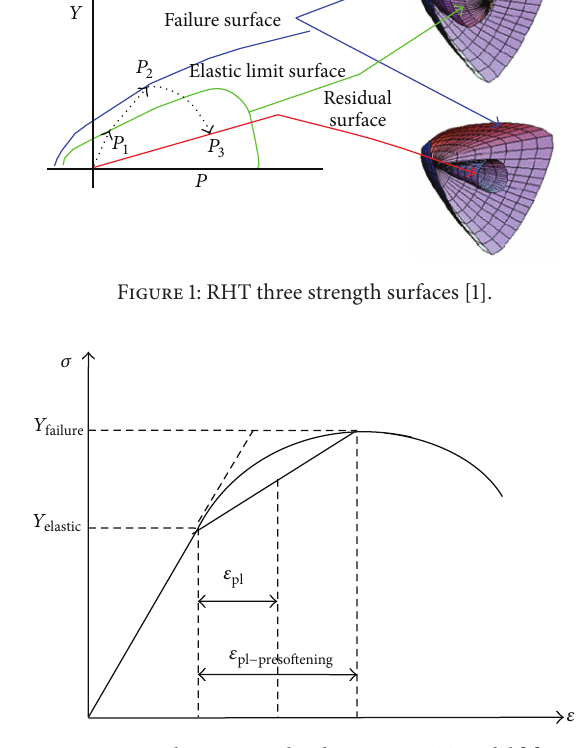
Figure 2: Bilinear strain hardening in RHT model